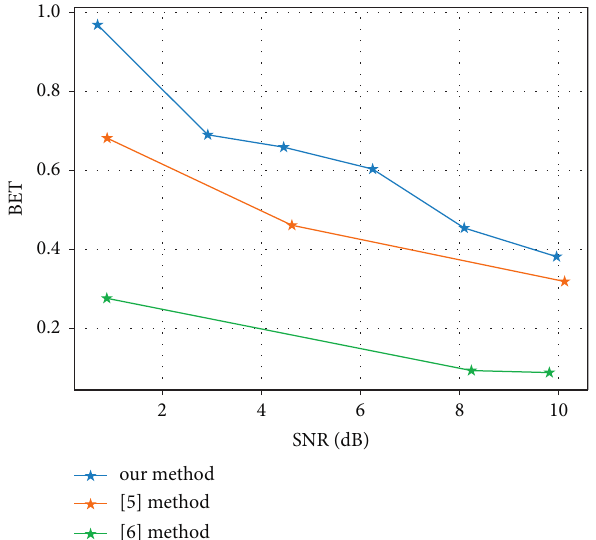
Figure 5: Comparative test of accuracy of English